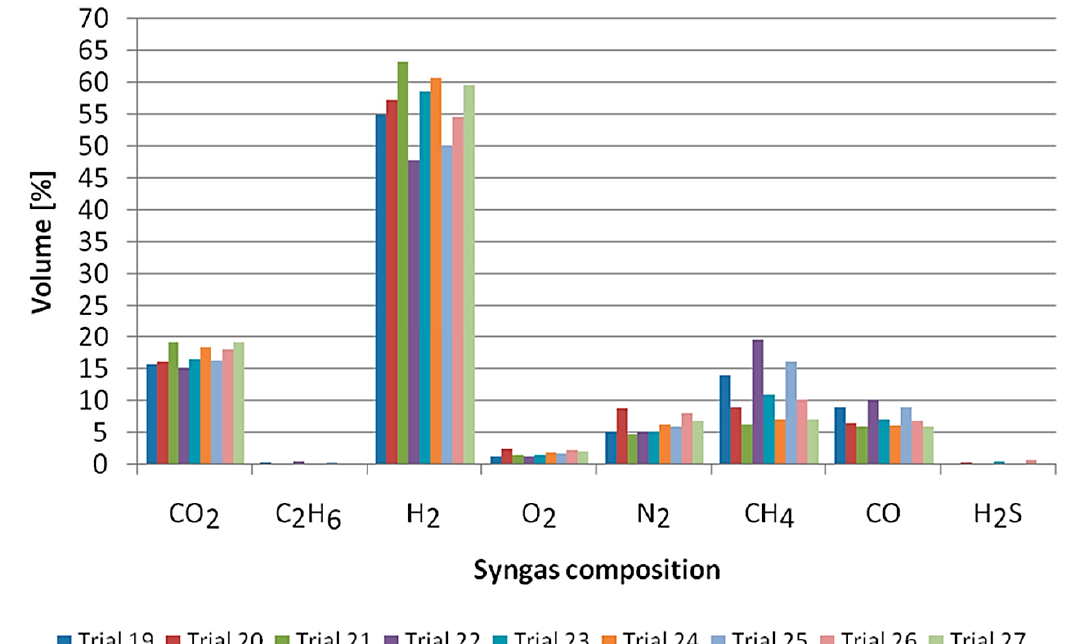
Figure 15. The effect of steam supply on the syngas composition during the gasification of the coal sample from hard coal mine C (on a dry basis).